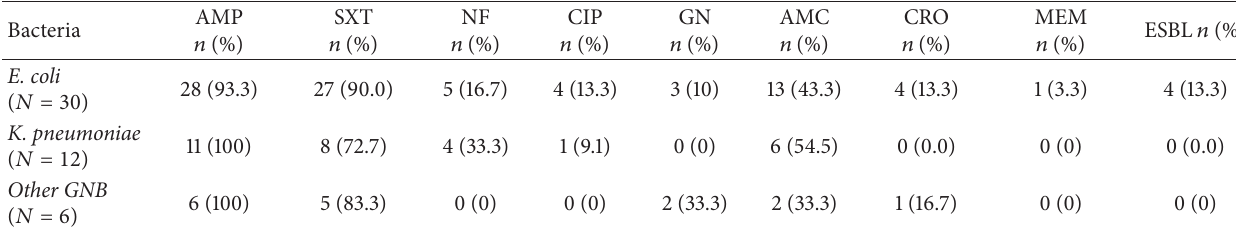
Table 3: Antimicrobial resistance profiles among Gram-negative bacteria